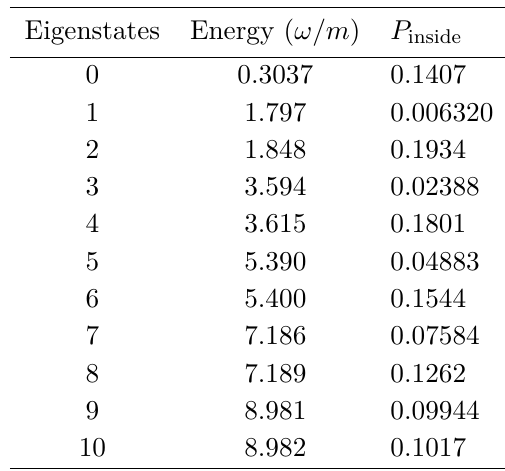
Table 2 . Eigenstates in the compactified dimension with l/L = 0 . 1 and mL = 3 . 5 .